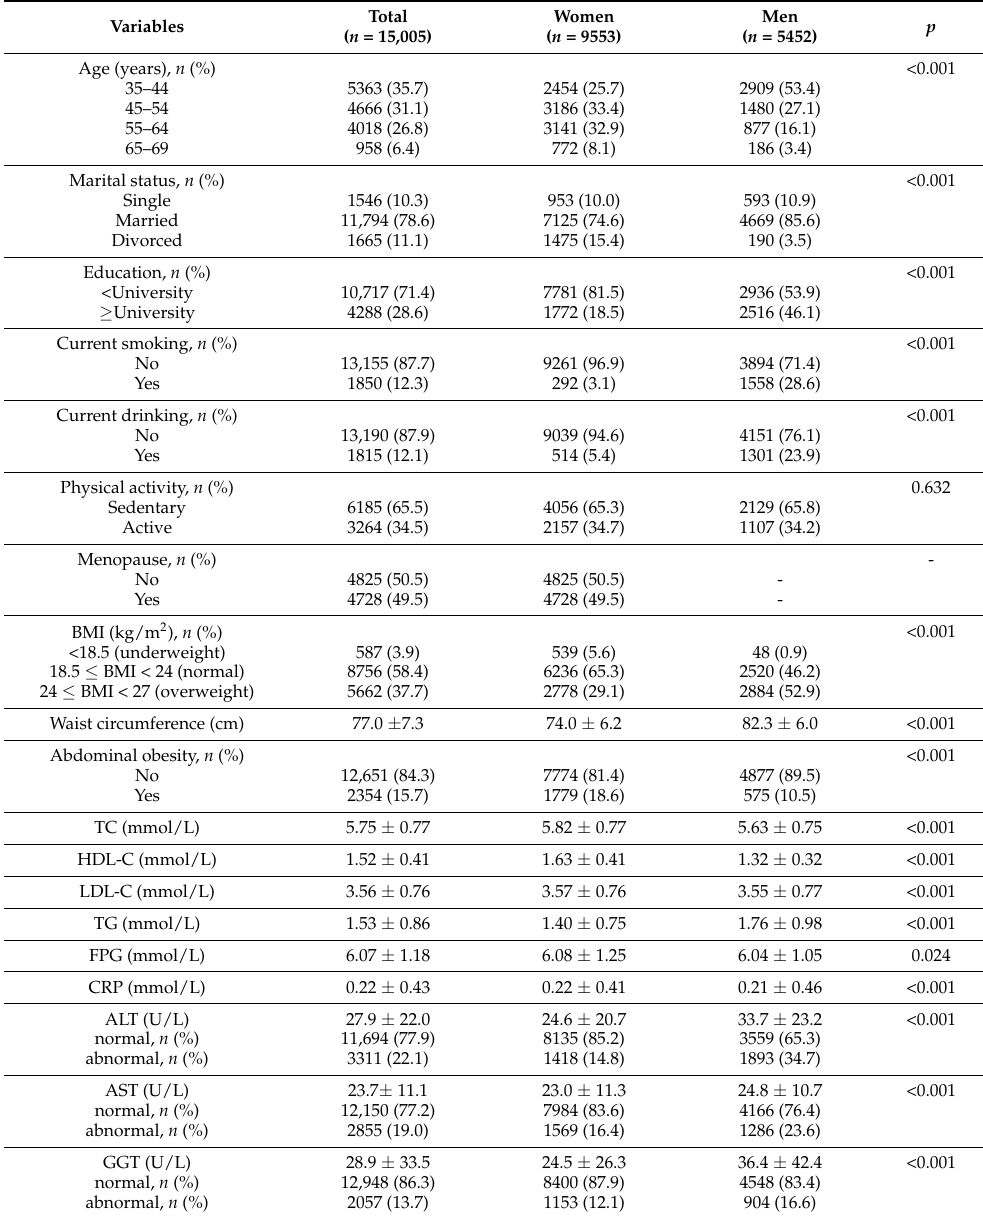
Table 2. Characteristics of the subjects ( n = 15,005) 1